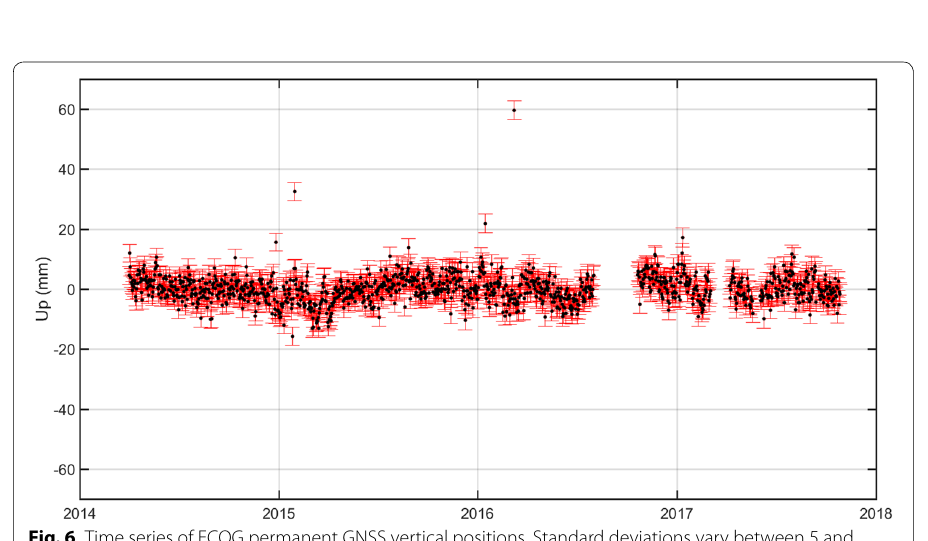
Fig. 6 Time series of ECOG permanent GNSS vertical positions. Standard deviations vary between 5 and 10 mm (From RéNaSS